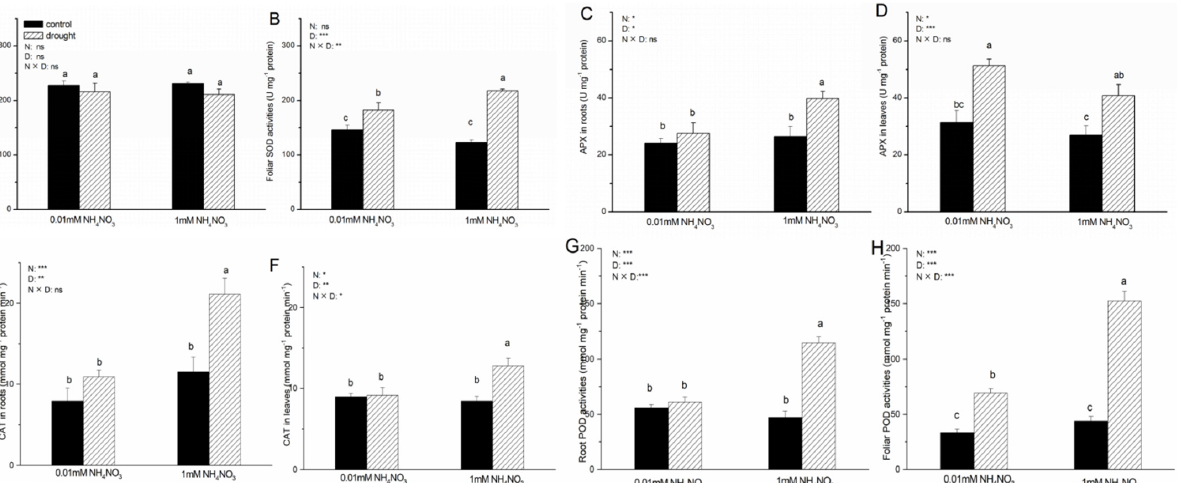
Figure 5. Activities of SOD, APX, CAT, and POD enzymes in roots ( A , C , E , G ) and leaves ( B , D , F , H ) of Populus simonii as affected by nitrogen supply and drought stress. Data indicate mean ± SE ( n = 6). Different letters in the same column indicate significant differences. N, N supply; D, drought treatment; N × D, interaction of N supply and drought treatment. *, p < 0.05; **, p < 0.01; ***, p < 0.001; ns, not significant.